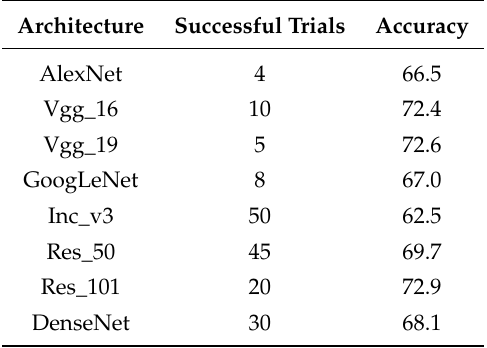
Table 8. Experimental results: Session #2, layer